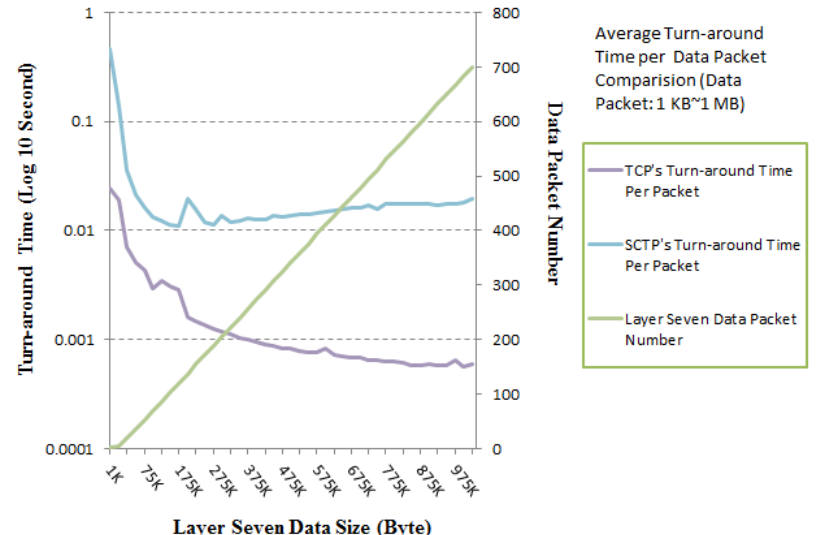
Figure 10. Turn-around time per packet comparison between TCP and SCTP-Tunnel for various data packet numbers: 1 KB–1